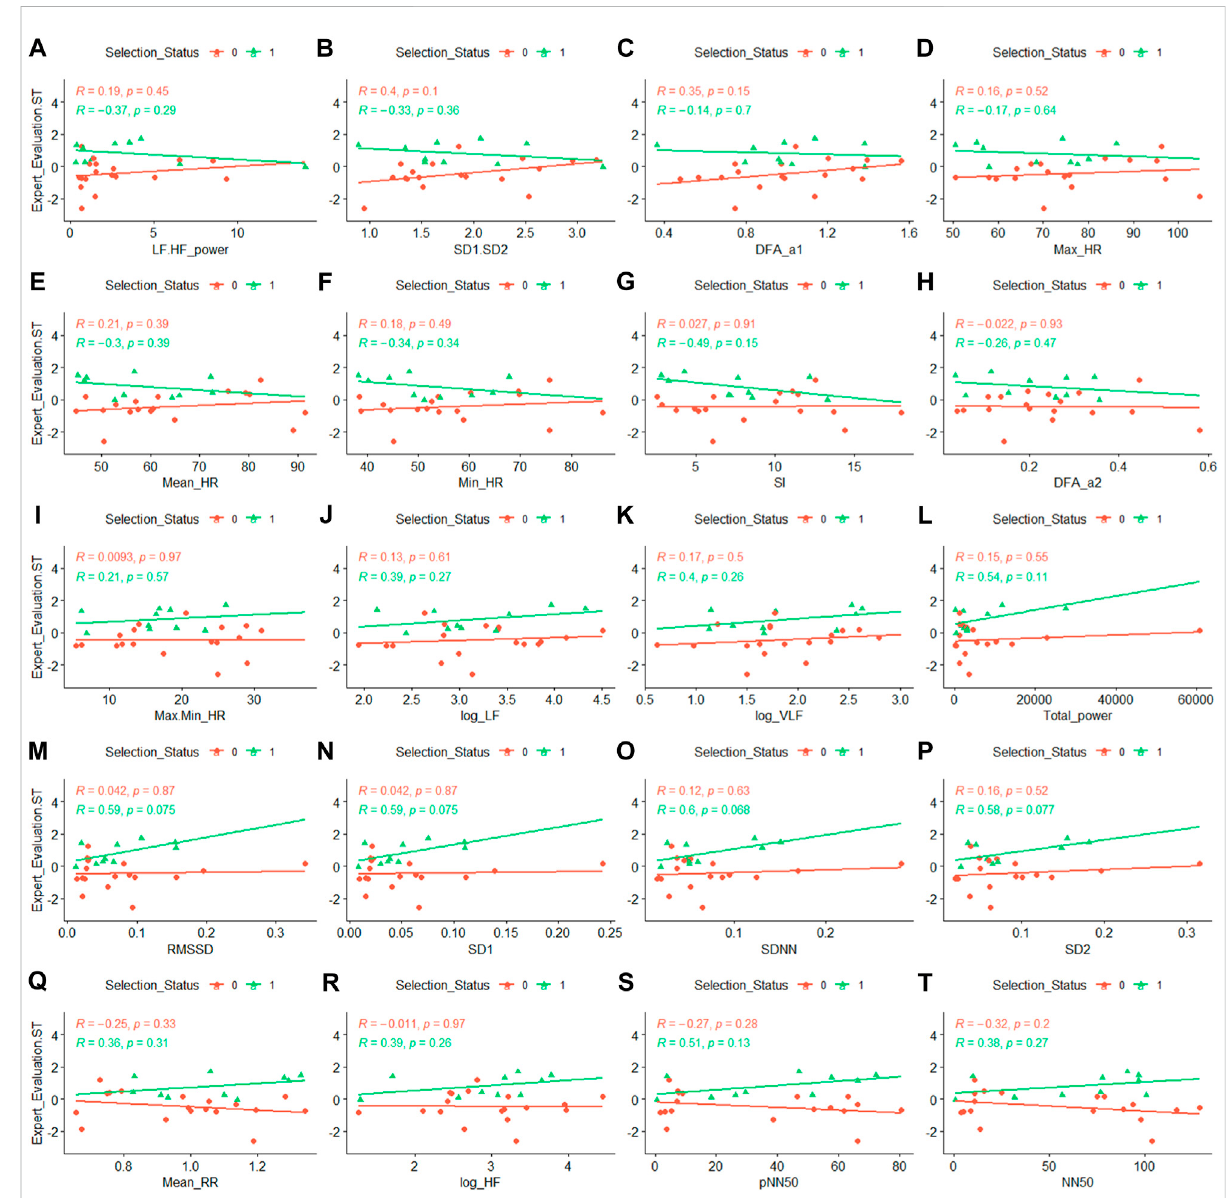
Correlation between Expert Evaluation-ST and HRV metrics by Selection Status. Selection Status of 0, shown in red with circular data points, indicates a non-selected participant, and Selection Status of 1, shown in green with triangular data points, indicates a selected participant. Abbreviations: ST, stress tolerance; HRV, Heart Rate Variability. Panel descriptions (A) LF.HF, Ratio of low frequency (LF) to high frequency (HF) band powers; (B) SD1.SD2, Ratio of Poincaré Perpendicular Standard Deviation (SD1) to Poincaré Parallel Standard Deviation (SD2); (C) DFA α 1, short- term detrended fl uctuation analysis; (D) Max Heart Rate; (E) Mean Heart Rate; (F) Minimum Heart Rate; (G) SI, Stress Index; (H) DFA α 2, long-term detrended fl uctuation analysis; (I) Max.Min HR,Heart Rate Range; (J) logLF, naturallog ofLF; (K) logVLF,natural log ofVery-LowFrequency; (L) Total Power; (M) RMSSD, Root Mean Square of Successive Differences; (N) SD1; (O) SDNN, Standard Deviation between R-R intervals; (P) SD2; (Q) Mean RR,R toR interval inECGrhythm; (R) logHF, natural log ofHF; (S) pNN50, percentageofsuccessive R-R intervals that deviate greater than 50 ms; (T) NN50, number of R-R intervals that deviate greater than 50